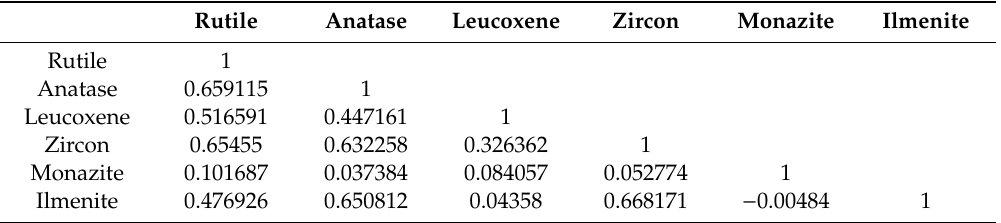
Table 2. Correlation matrix of heavy minerals.